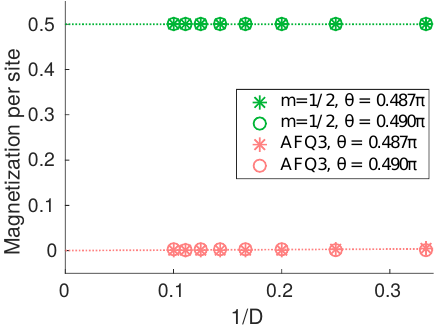
Figure 11: Magnetization per site for the half magnetized half nematic ( m = 1 / 2) and the three-sublattice antiferroquadrupolar (AFQ3) states left and right of the phase transition at θ = 0.4886 ( 7 ) π for D = 3,4,...,10. The former clearly extrapolates to 1 / 2, the latter to zero. Hence, the transition is of first order.